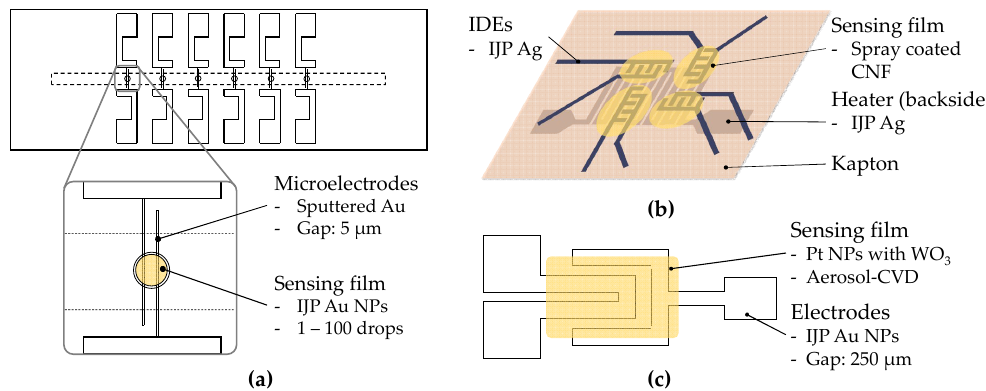
Figure 3. Partly printed sensors using Au and Pt as the sensing material: ( a ) Au NP-based sensing film [22,23]; ( b ) Au NP decorated sensing film [32]; ( c ) Pt NP-based sensing film [34].